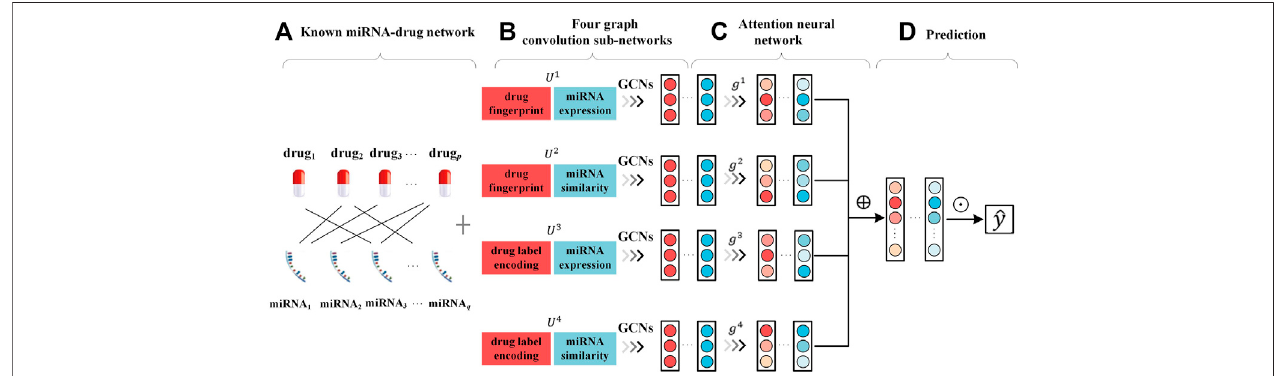
FIGURE 1 | Framework of proposed method AMMGC (A) . Known miRNA-drug resistance association network. (B) . Learning node embeddings independently from four graph convolution sub-networks based on different feature combinations. (C) . Applying an attention neural network to learn attentive node embeddings. ⊕ denotes the concatenation operation. (D) . Using embeddings of drugs and miRNAs to produce the scores of miRNA-drug pairs. ⊙ denotes the inner product of drug embeddings and miRNA embeddings.